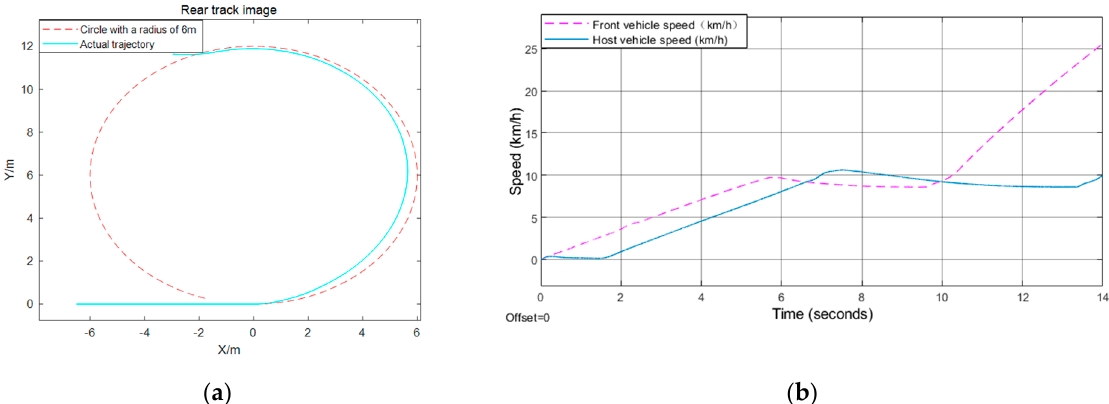
Figure 8. U ‐ turn test result: ( a ) rear track image; ( b ) front and rear vehicle speed. Figure 8. U-turn test result: ( a ) rear track image; ( b ) front and rear vehicle